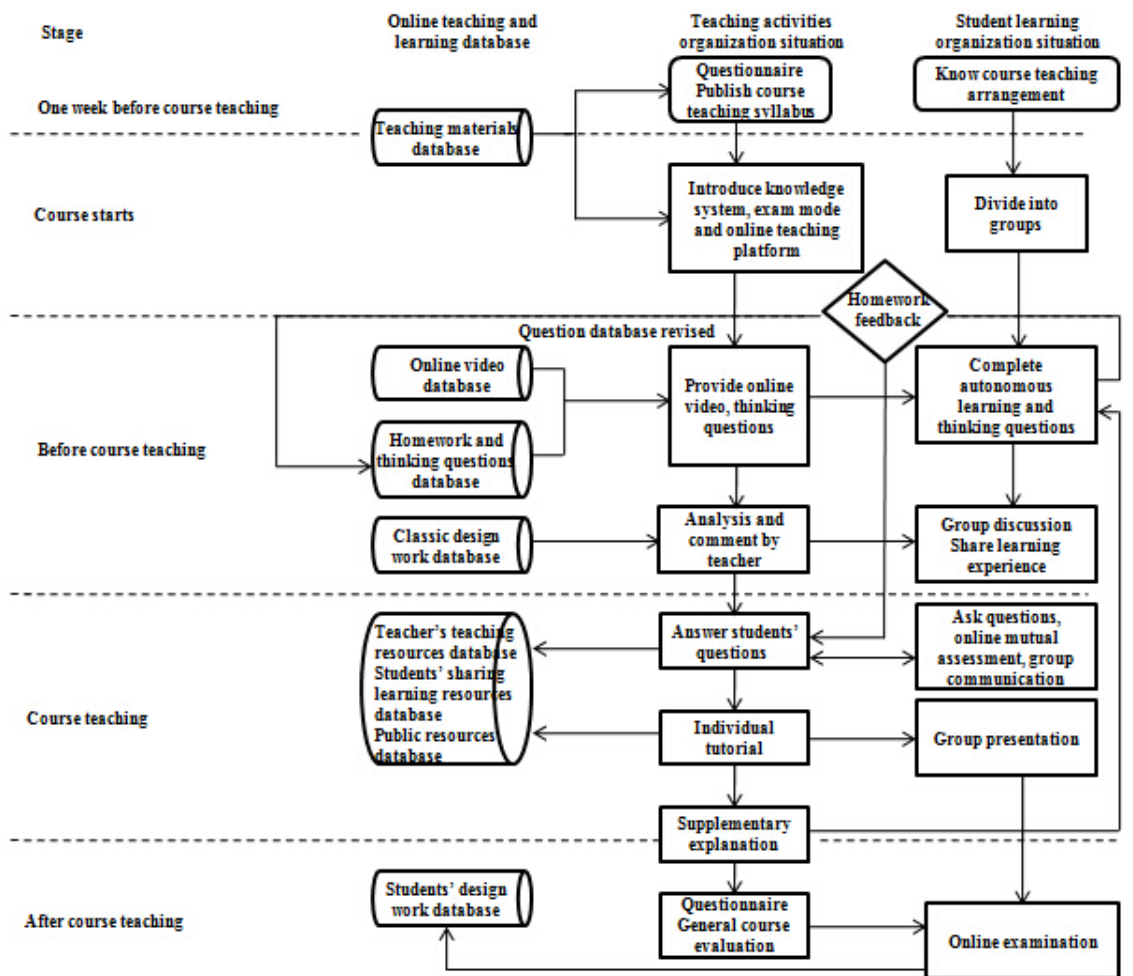
Figure 6. Flow chart of flipped classroom teaching mode in Modern Design